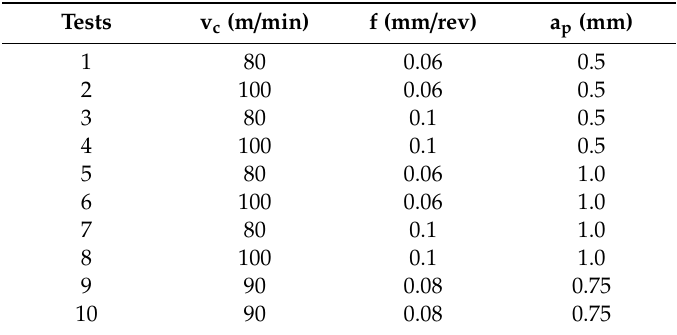
Table 2. Factorial design used for machining.